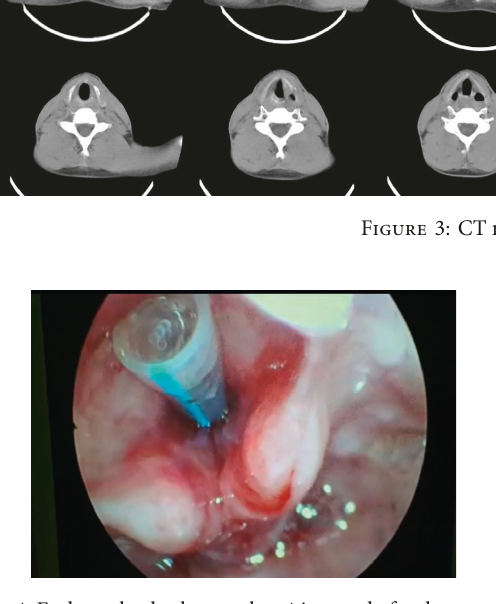
Figure 4: Endotracheal tube number 4 inserted after laser-assisted release of stenosis.